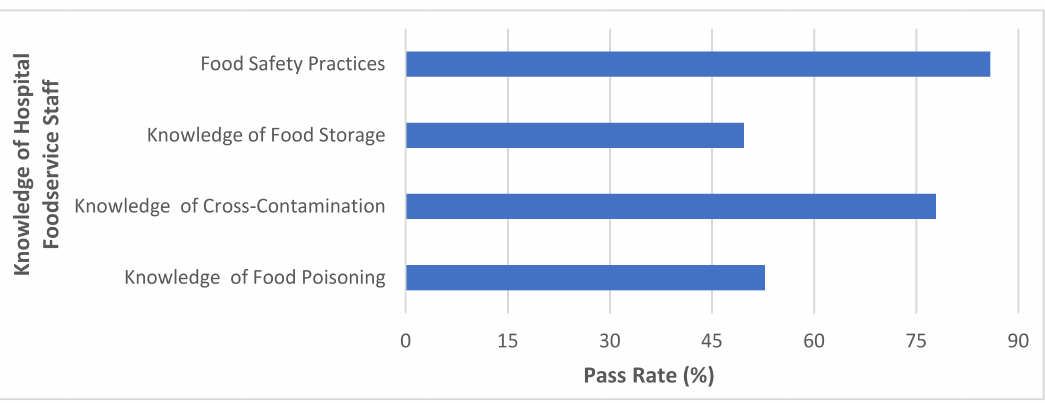
Figure 1. Pass rate for food safety knowledge and practices among foodservice